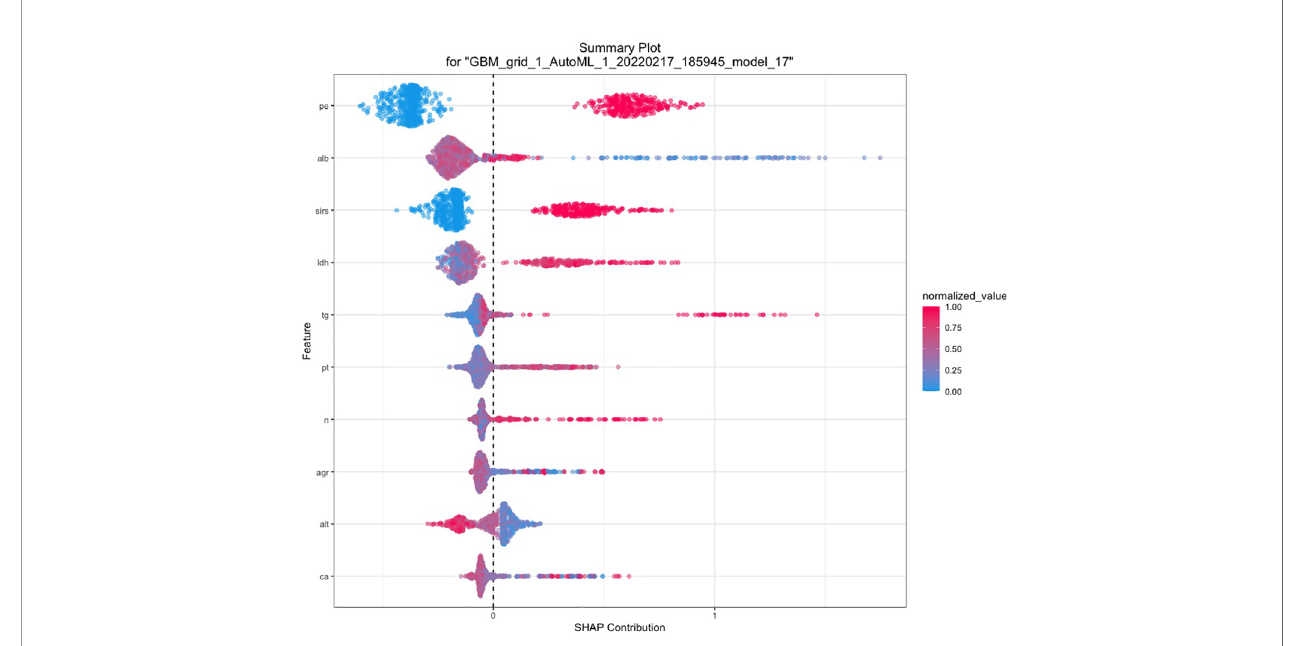
FIGURE 4 | SHAP of the GBM model in the training set. The closer the values of the variables were to 1, the more likely patients were to progress to severity acute pancreatitis. SHAP, SHapley additive explanation; PE, pleural effusion; ALB, albumin; SIRS, systemic in fl ammatory response syndrome; LDH, lactic dehydrogenase; TG, triglyceride; PT, prothrombin time; n, neutrophil count; AGR, ratio of albumin to globulin; ALT, glutamic-pyruvic transaminase; Ca, Ca 2+